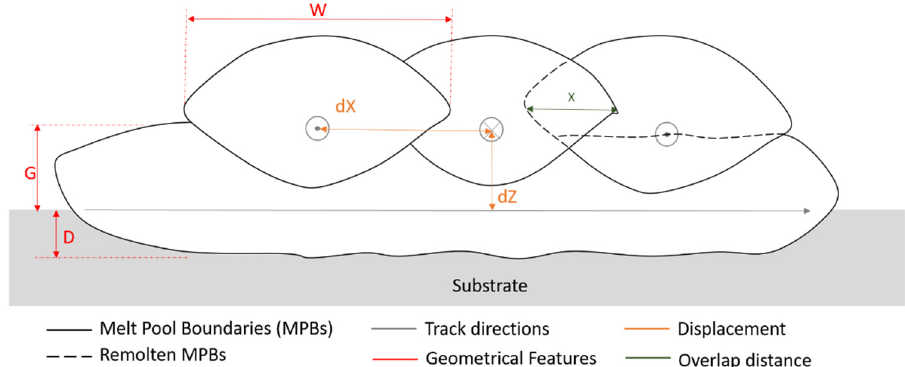
Figure 3. Schematic representation of two LP-DED layers build with no growth overlap and the 0/90° scanning strategy with bidirectional scanning in each layer.